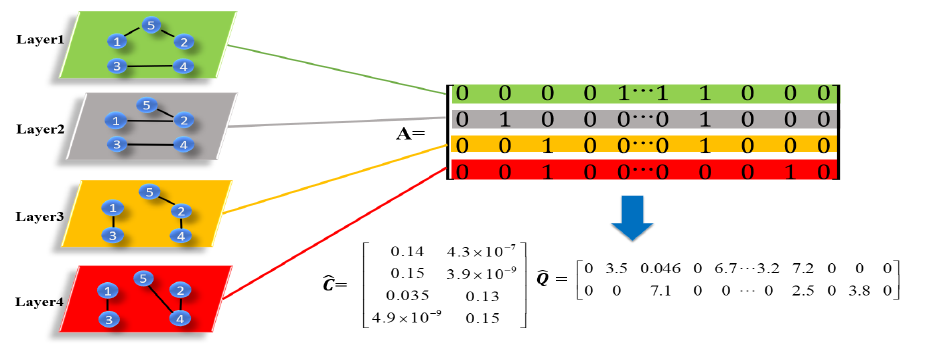
Figure 1. A toy example describes how to estimate C and Q in the objective function Equation